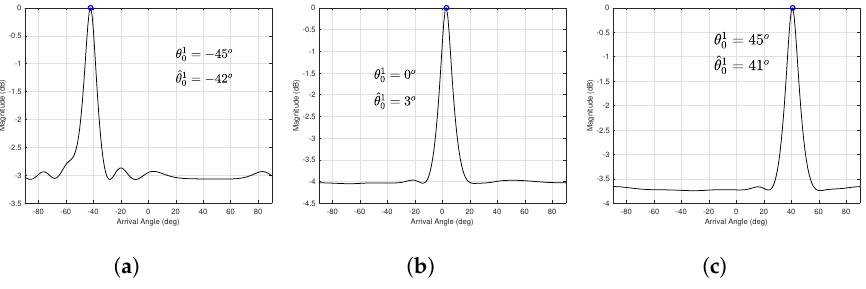
= − 45. ( b ) For θ 1 = 0. ( c ) For θ 1 = 0 0 0